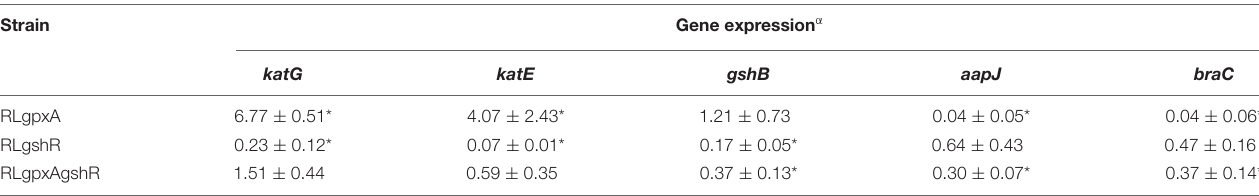
TABLE 2 | Expression of genes in R. leguminosarum strains growing in AMS medium by qRT-PCR analysis.